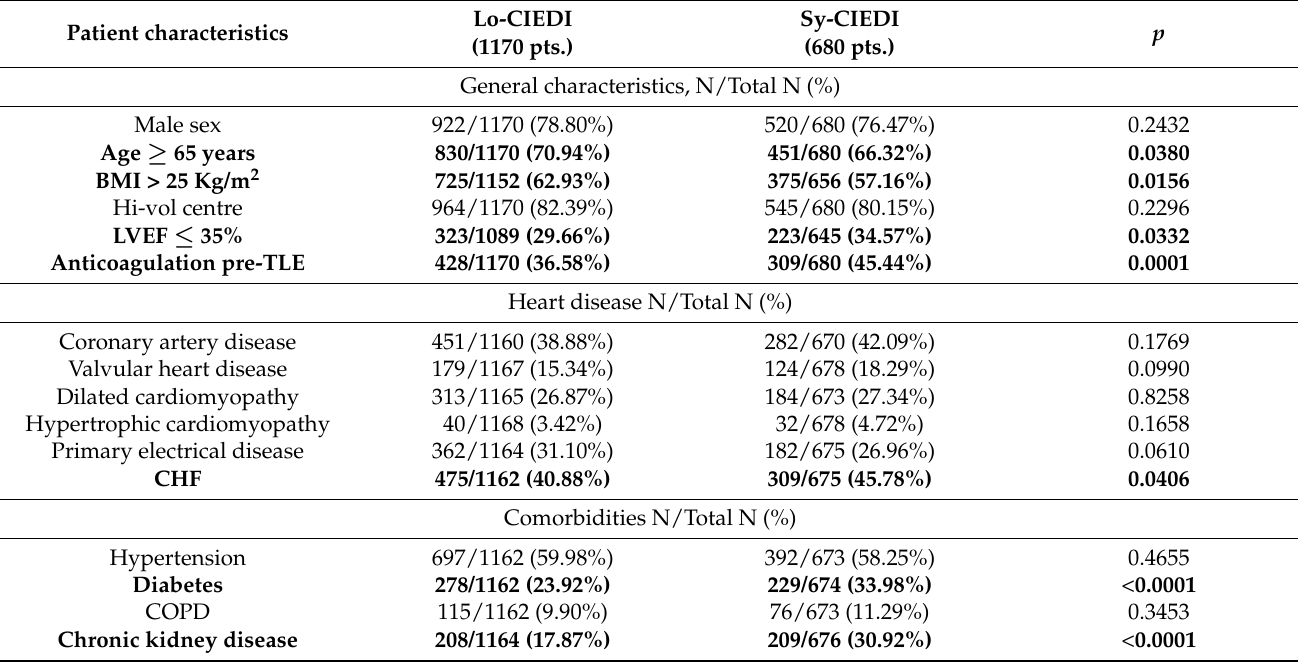
Table 1. Baseline clinical characteristics of patients with Lo-CIEDI vs.